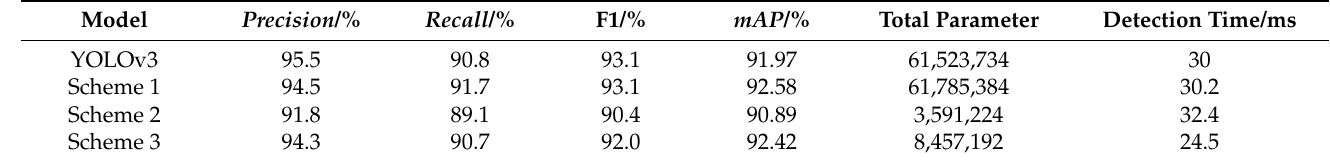
Table 4. Yolov3 model